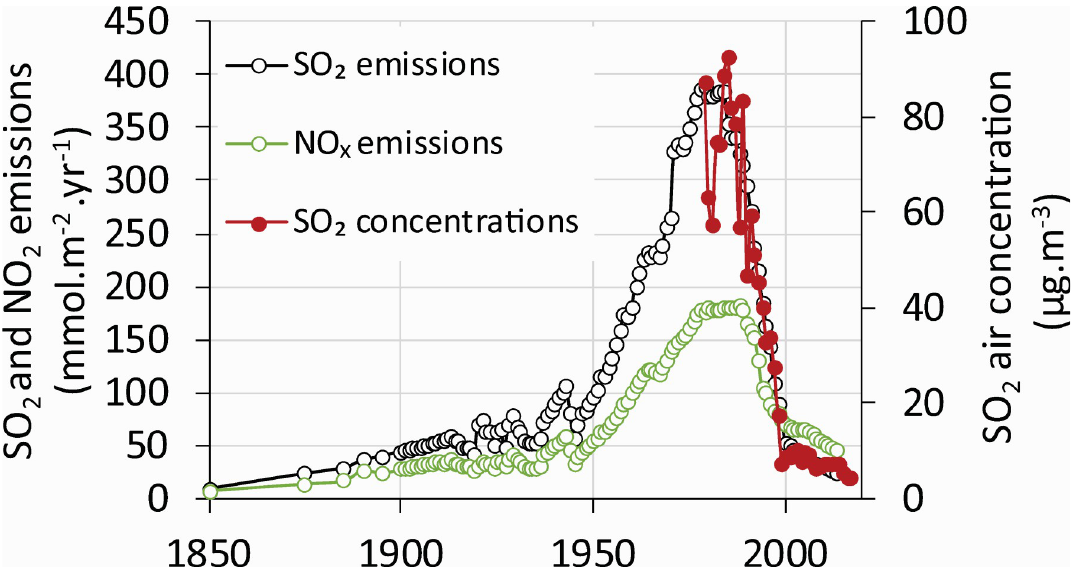
Fig 3. SO 2 emissions (Czech Republic) between 1850–2017 and ambient annual SO 2 concentrations measured at Cı´novec (Zinwald) at the Czech/German border between 1979–2017.